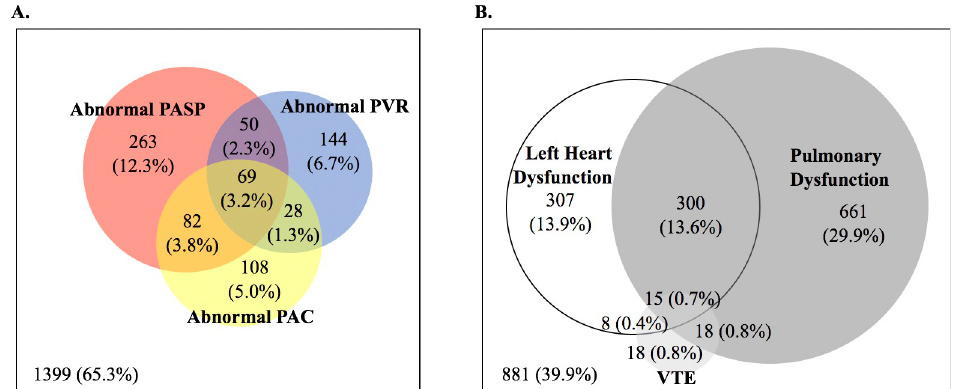
Fig 1. Prevalence of abnormal pulmonary vasculature measures and pulmonary functional. (A) Overlap between abnormal PASP, PVR, and PAC defined using ARIC-based reference limits. (B) Overlap between left heart disease, pulmonary dysfunction, and VTE. ARIC, Atherosclerosis Risk in Communities; PAC, pulmonary arterial compliance; PASP, pulmonary artery systolic pressure; PVR, pulmonary vascular resistance; VTE, venous thromboembolism. PVR (S5 Table) and when further excluding an additional 227 participants with moderate or severe dyspnea and European Society of Cardiology Heart Failure Association (ESC HFA) cri- teria for HFpEF ( n = 196) and also those with LVEF < 50% ( n = 31; S6 Table). Pulmonary dysfunction demonstrated associations of similar magnitude with all pulmo- nary vascular measures, which appeared to be driven by associations with restrictive ventila- tory deficit as opposed to COPD (S4 Table). Prior VTE was not associated with abnormalities in any pulmonary vascular measure. Left heart dysfunction demonstrated the highest PAR for abnormally high PASP (20%), whereas pulmonary dysfunction had the highest PAR for abnor- malities of PAC (19%; Fig 2; Table 2).